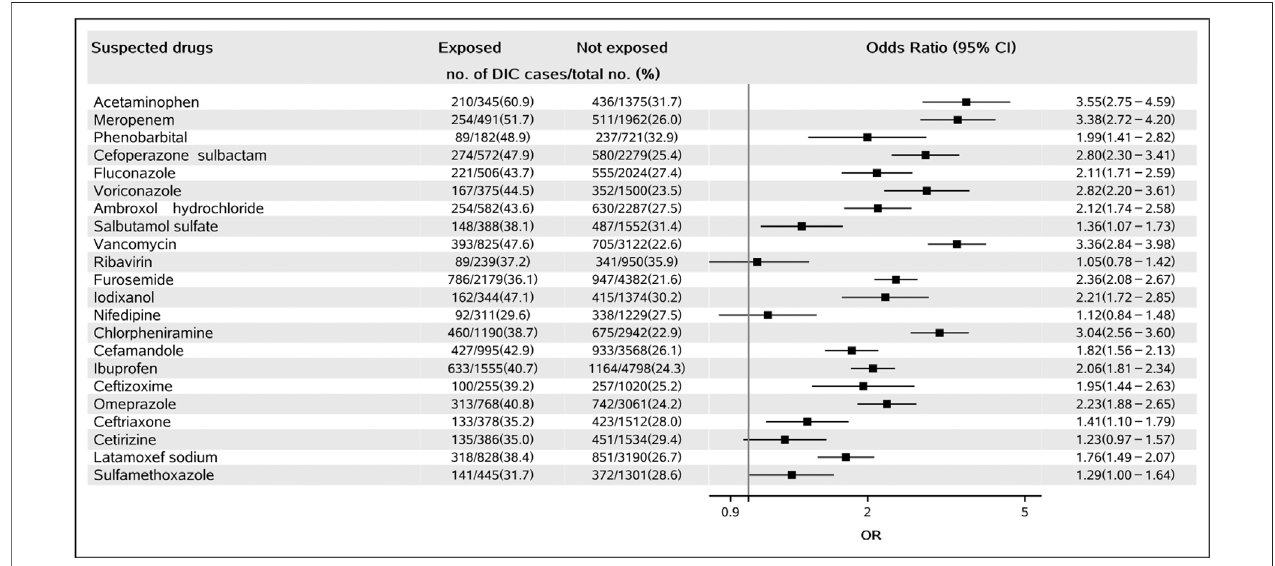
FIGURE 2 | Forest plot for the association of suspected drugs and DIC. Abbreviations: DIC, drug-induced coagulopathy.